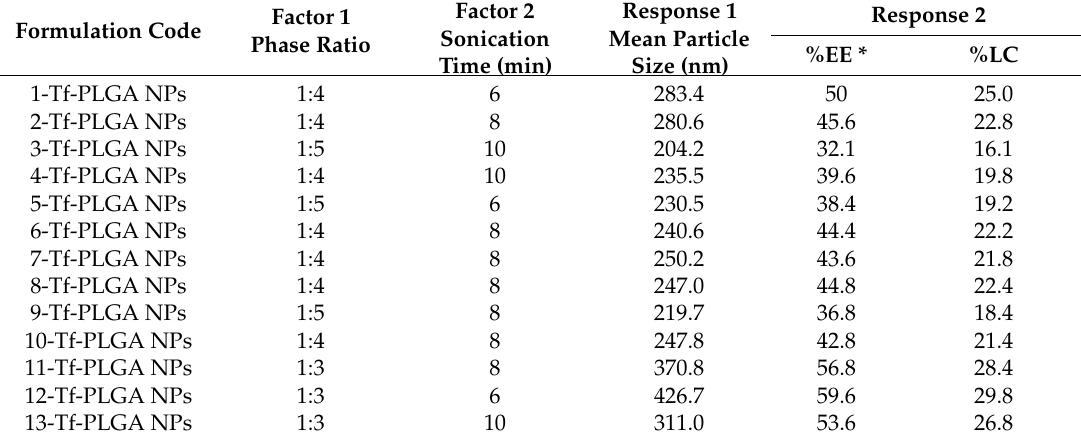
Table 2. The e ff ect of the chosen independent variables (factors) on the dependent variables (mean particle size and encapsulation e ffi ciency). Loading capacities were also calculated for the 13